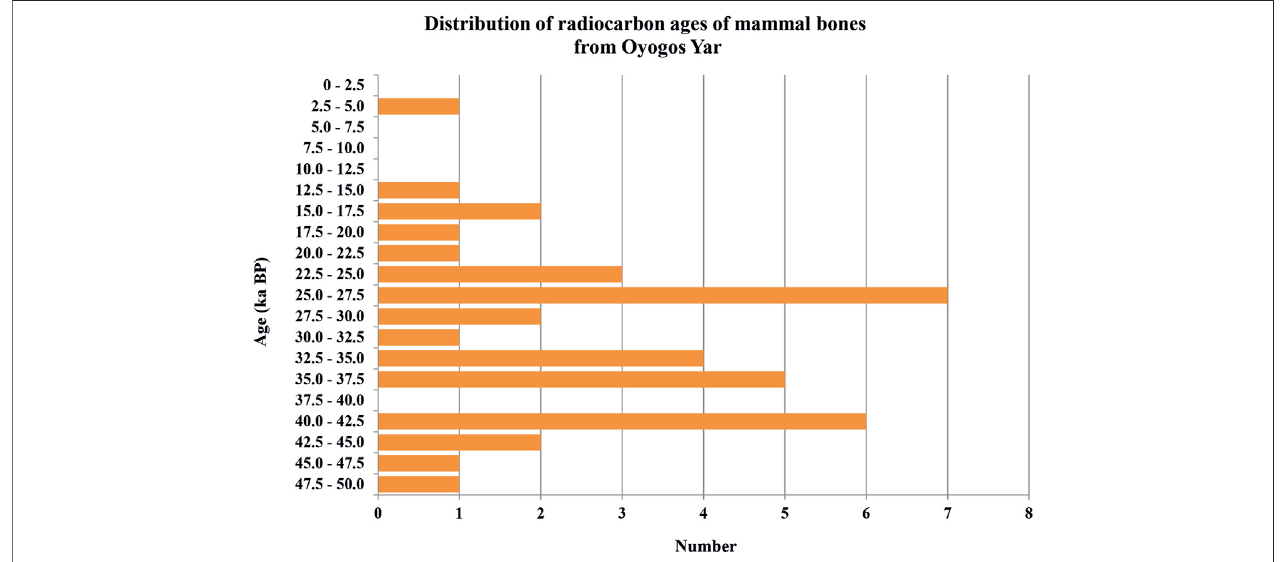
FIGURE7| Distributionofradiocarbonagesofmammalbones(38)fromtheOyogosYar coastincludingdatafromNikolskiyetal.,2011(N=20),Boeskorovet al., 2013 (N = 2), Rompler et al., 2006 (N = 1), and this study (N = 15). Only fi nite dates are given as uncalibrated ages.